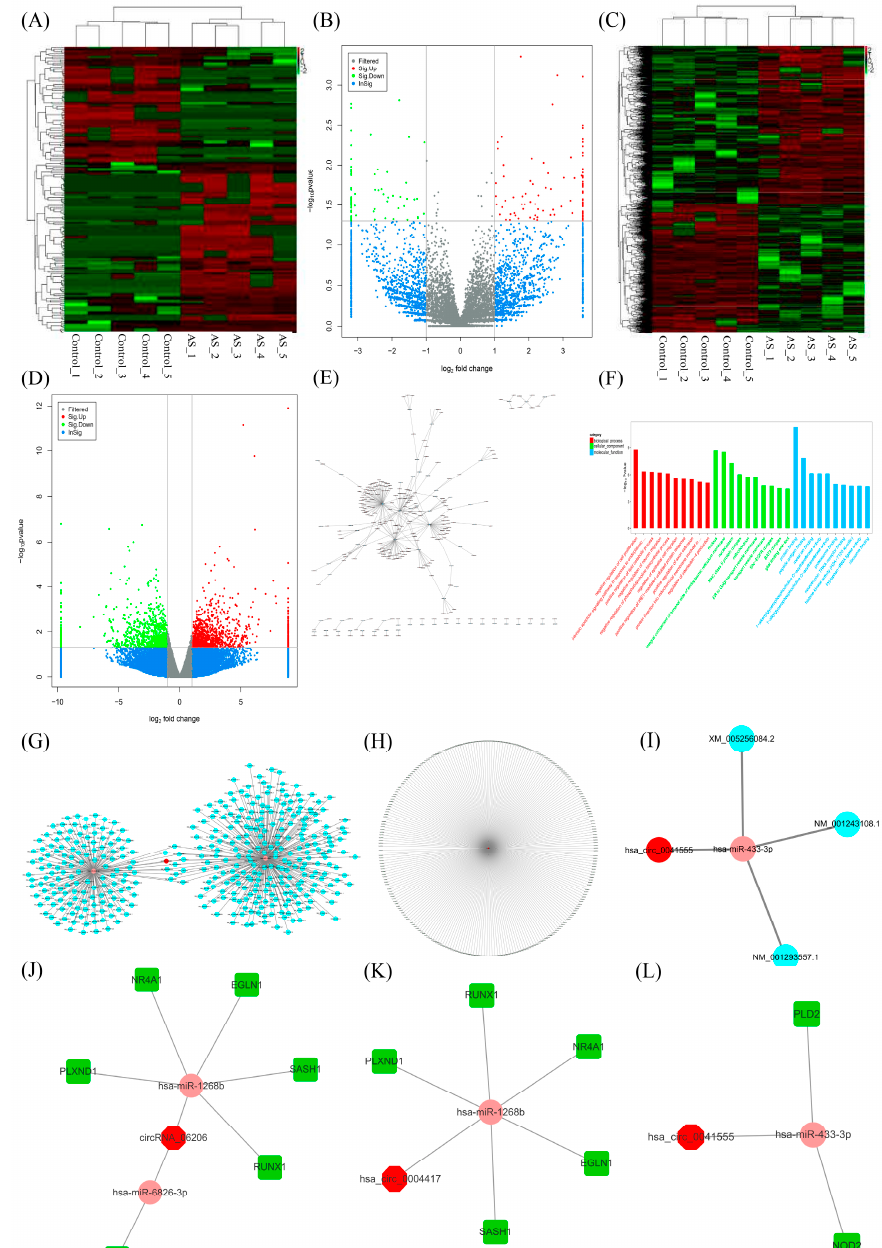
Figure 1. Identification of differentially expressed (DE) circular RNAs (circRNAs), DE messenger RNAs (mRNAs) and circRNA–microRNA (miRNA)–mRNA networks based on RNA sequencing data analysis of samples from atherosclerotic patients. ( A ) Heatmap of the DE circRNAs between atherosclerotic patients (AS) and healthy volunteers (control). Red indicates high intensity, green indicates low intensity, and black indicates medium intensity. ( B ) Volcano plot of DE circRNAs; green dots represent low DE circRNAs, and red dots represent high DE circRNAs with statistical significance. ( C , D ) Heatmap and volcano plot of the DE mRNAs between atherosclerotic patients (AS) and healthy volunteers (control). ( E ) The overlapping miRNAs predicted as downstream tar- gets of the DE circRNAs, and the top 300 circRNA ‒ miRNA networks were established. ( F ) Gene